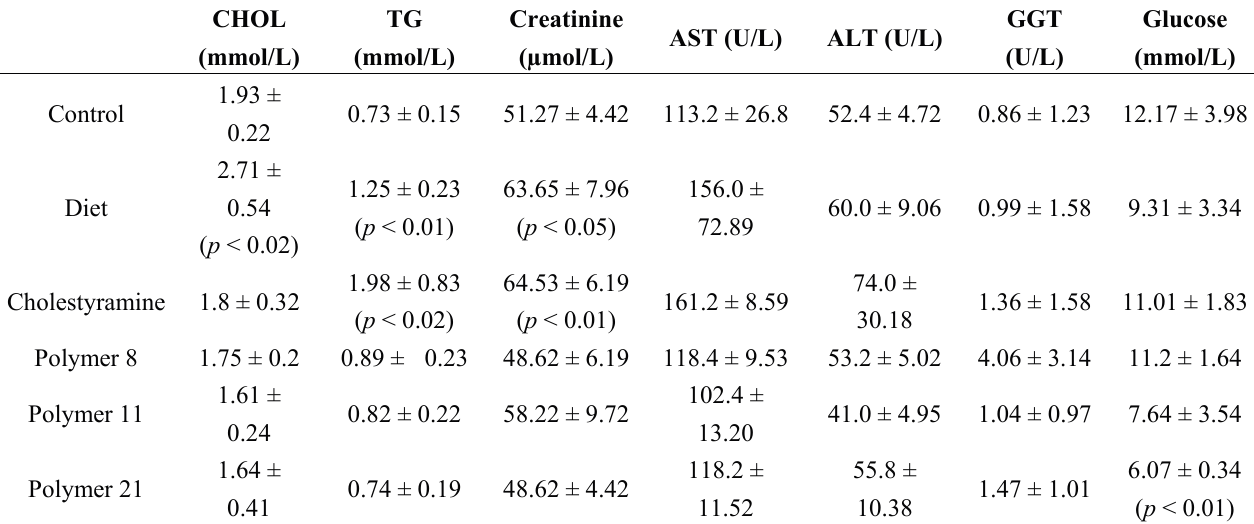
Table 2. Clinical chemistry analysis. Mean values and standard deviation from the five animals comprising each group. Those parameters whose differences with the control group are statistically significant are shown in bold and the resulting p-values in brackets. Animals were fed with conventional diet (control), conventional diet supplemented with 2% (w/w) CHOL (diet), or with diet for two weeks and two extra weeks with